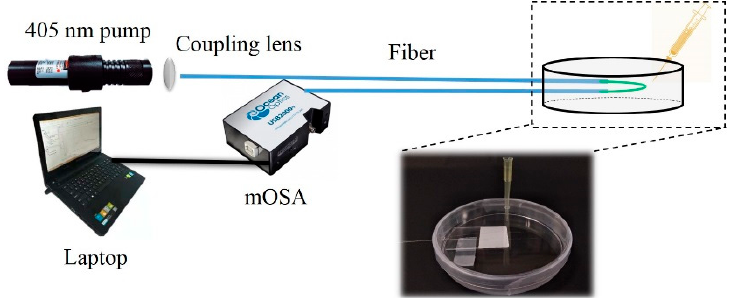
Figure 3. The schematic diagram of the test system.